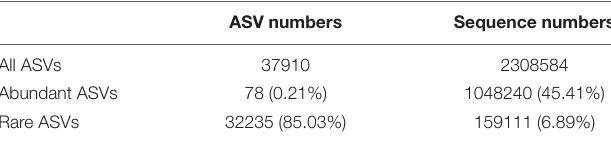
TABLE 1 | General description of all, abundant, and rare ASVs datasets at 100% sequence similarity